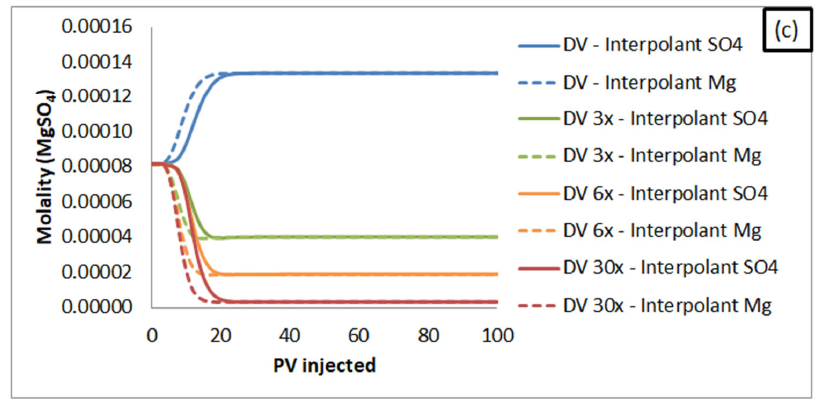
Figure 8. MgSO 4 concentration in the effluent for brine injection: ( a ) STD; ( b ) MV and ( c ) DV.